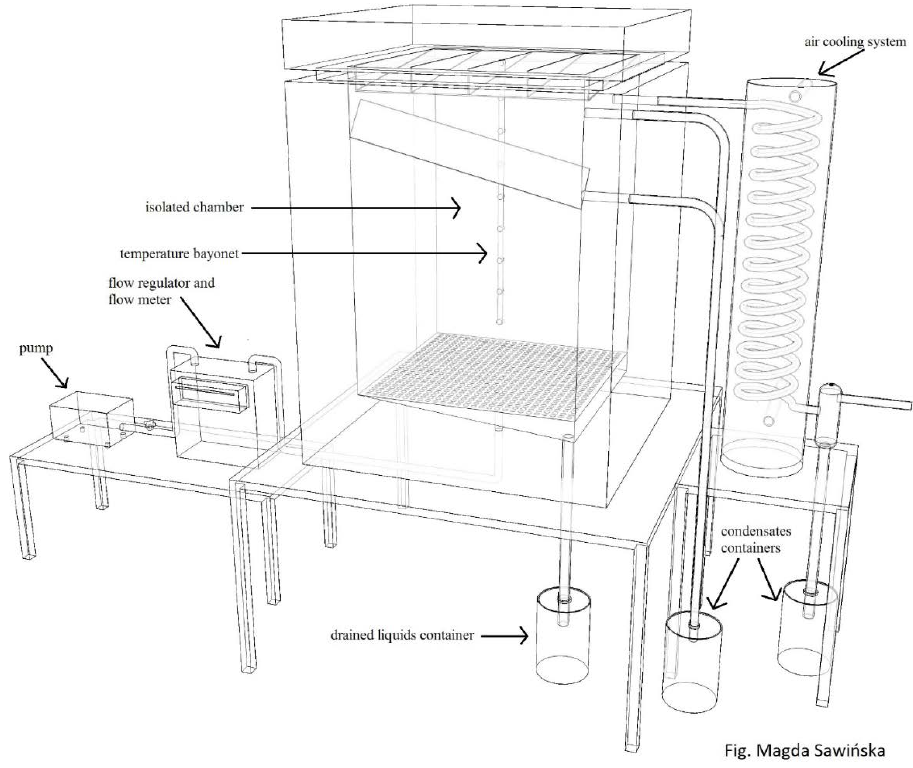
Figure 2. The scheme of the bioreactor used for studying the composting process. The total fresh weight of the mixtures intended for composting was 36 kg (K1), 44.5 (K2) and 42 kg (K3). In each of these mixtures, the base substrate was cabbage leaves (20